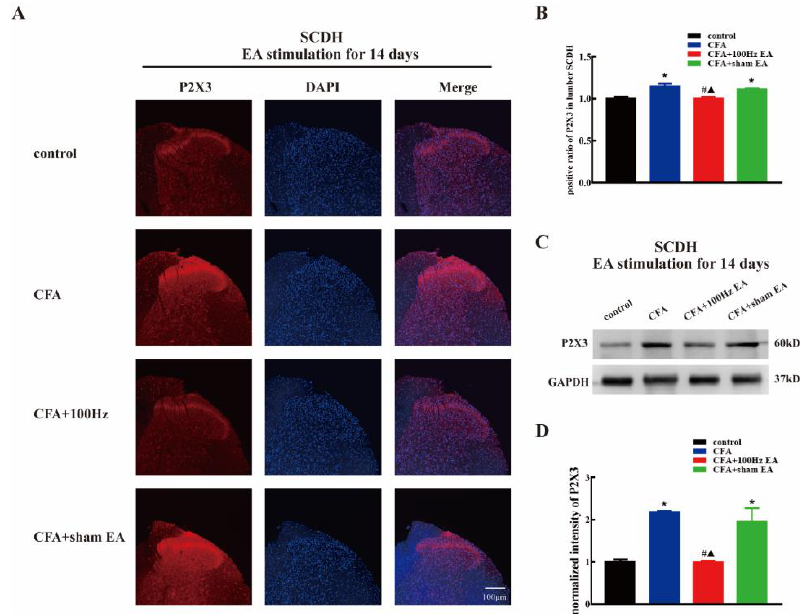
Figure 5. The 100 Hz EA stimulation for 14 days inhibited the up-regulation of P2X3 in the SCDH of inflamed rats. ( A ) Representative images of SCDH immunofluorescence staining from the control, CFA, CFA + 100 Hz EA and CFA + sham EA groups. Scale bars = 100 μm. ( B ) Mean intensity analysis of P2X3-ir in the SCDH in each group. Data are presented as the mean ± SEM, n = 3. ( C ) Representative western blotting images of SCDH in each group. ( D ) Relative protein level of P2X3 in the SCDH from different groups. Data are presented as the mean ± SEM, n = 6. * P <0.05, compared with the control group; # P < 0.05, compared with the CFA group; ▲ P < 0.05, compared with the CFA + sham EA group.